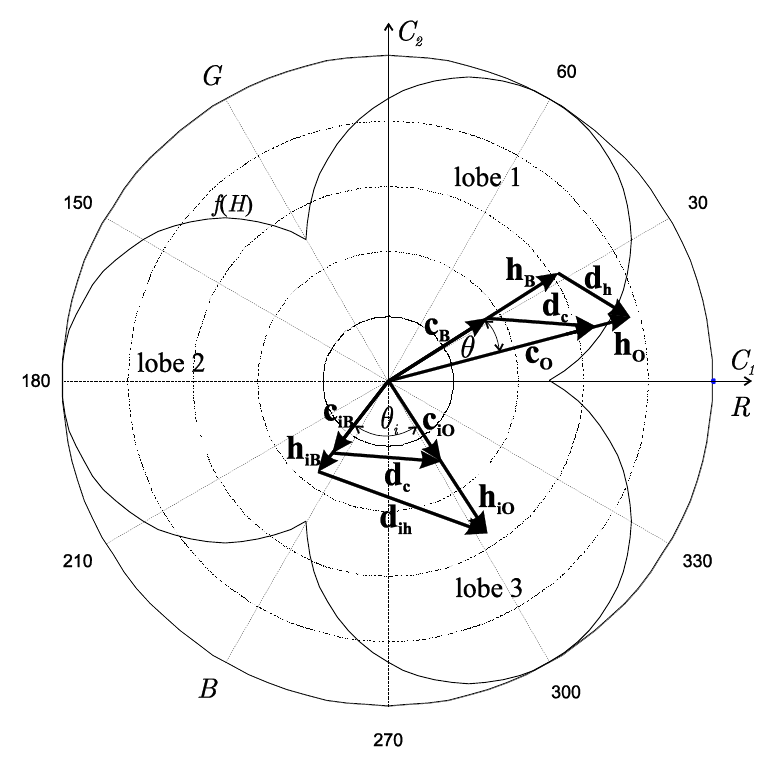
before and after the colour injection is c